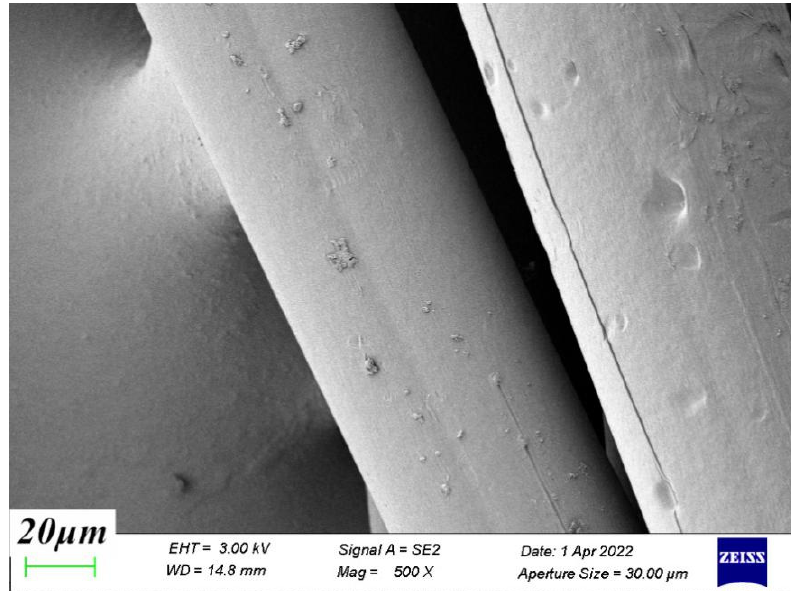
Figure 12. Polypropylene fiber.